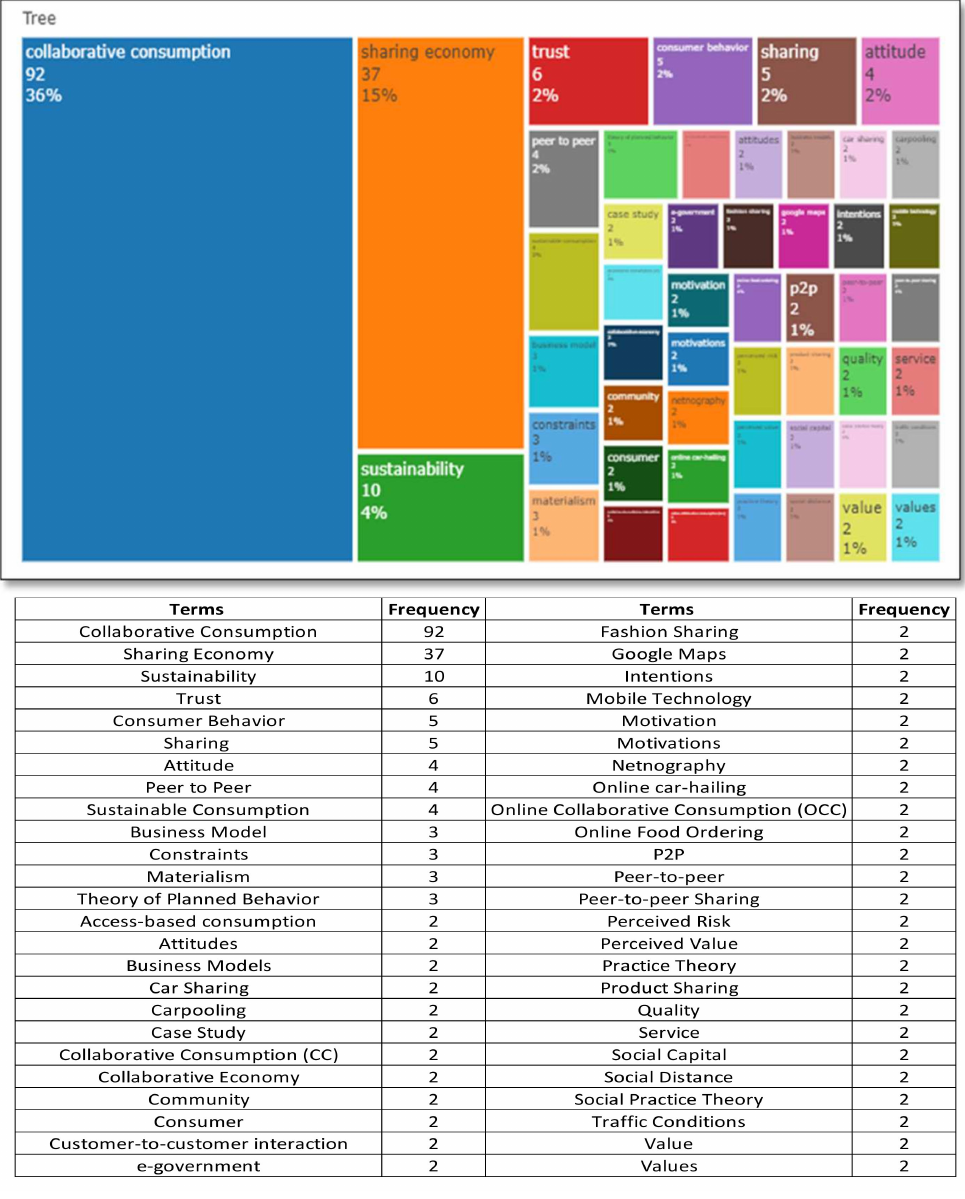
Figure 3. The collaborative consumption treemap. Source: R-Studio for Bibliometrix